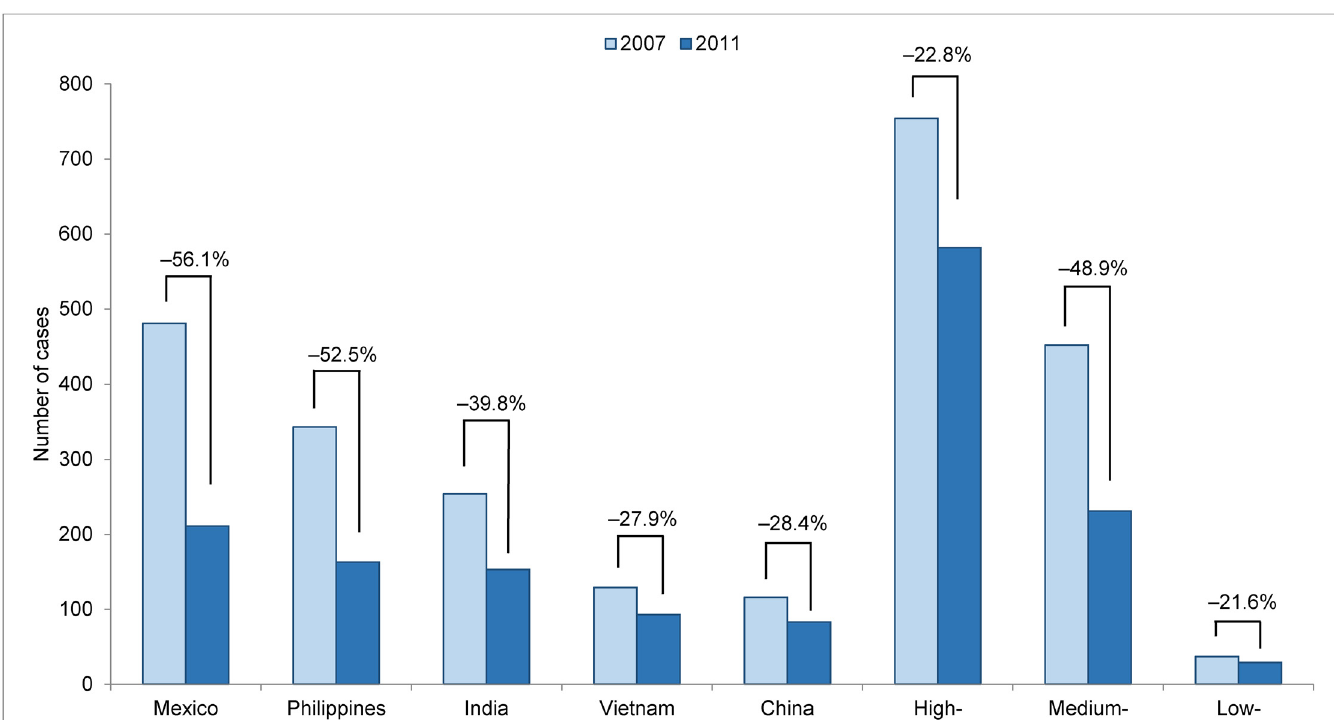
Fig 3. Tuberculosis case counts and percent decline among recent entrants, by country of origin or tuberculosis incidence in country of origin, 2007 and 2011. Light shaded bars represent tuberculosis case counts in 2007, and dark shaded bars represent tuberculosis case counts in 2011. Percentages indicate the percent decline in case count for each group during 2007 – 2011. Recent entrants are foreign-born persons with < 3 years since U.S. entry. The top five countries of origin accounting for the greatest number of tuberculosis cases among foreign-born persons in the United States are listed; cases among persons from other countries are classified according to tuberculosis incidence in the country of origin as low ( < 15 cases/100,000 persons), medium (15 – 99 cases/100,000 persons), or high ( (cid:1) 100 cases/100,000 persons). Countries with unknown incidence rates were excluded. All incidence rates used to categorize countries of origin are from World Health Organization data [1] and expressed per 100,000 persons.